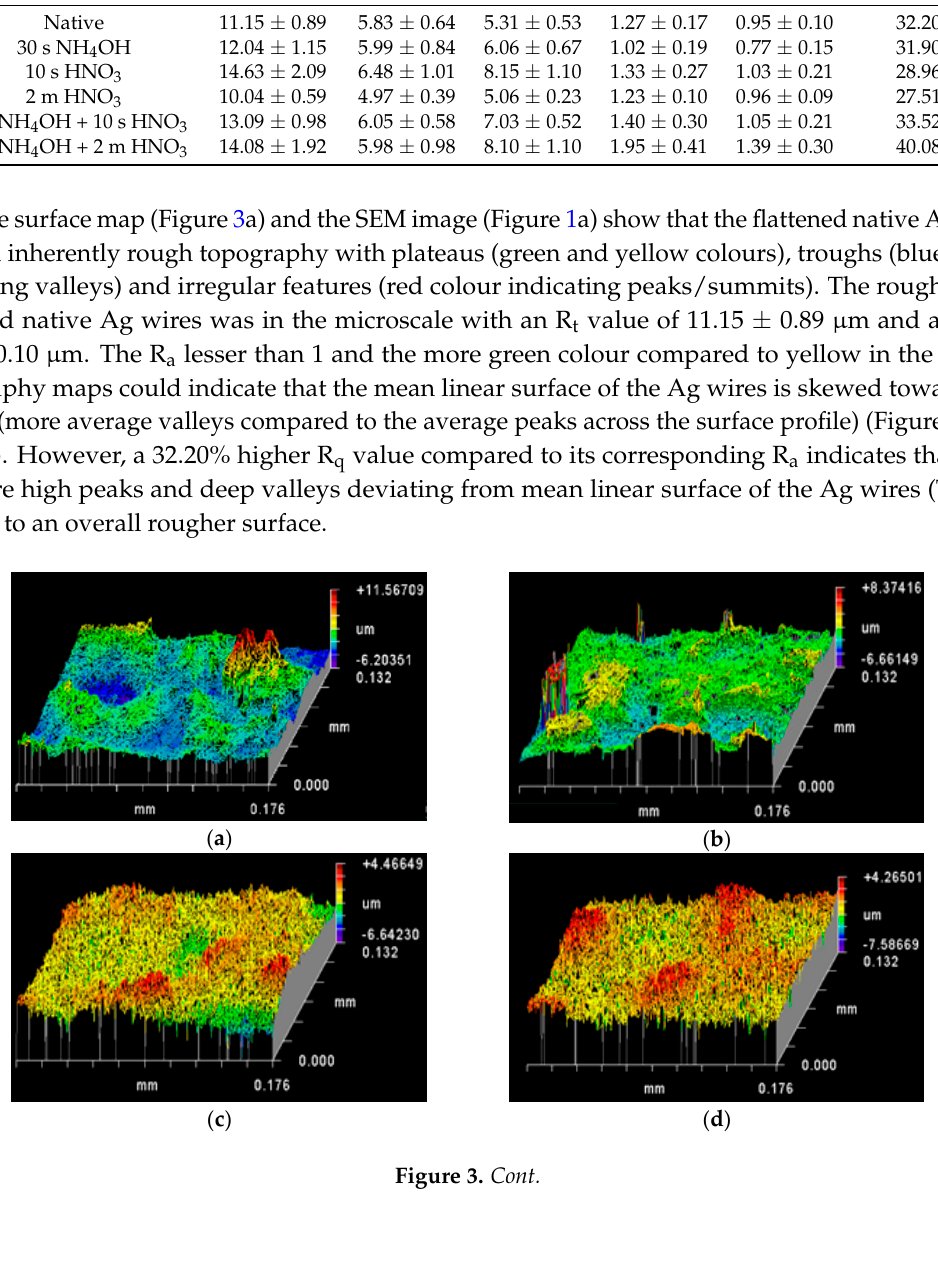
Table 1. Surface (area) roughness data for the native flattened Ag wire and the different flattened Ag wires after chemical etching treatments. ( n = 6, mean ± standard error of mean).